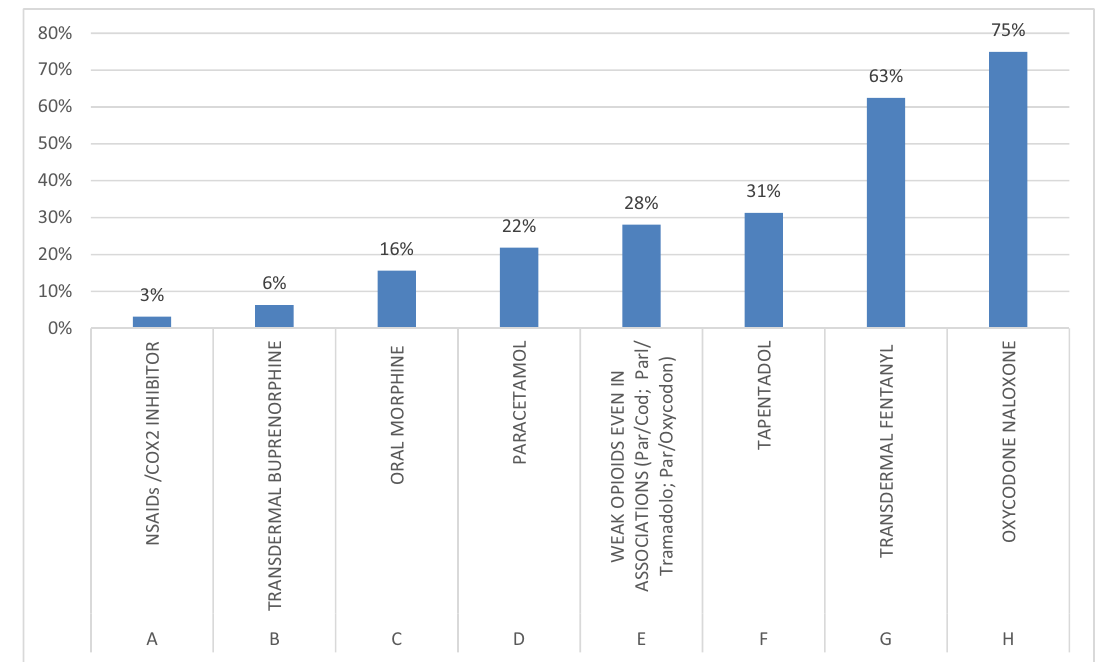
Figure 2: Survey question: “ In the management of cancer pain, which drug do you use mainly?.